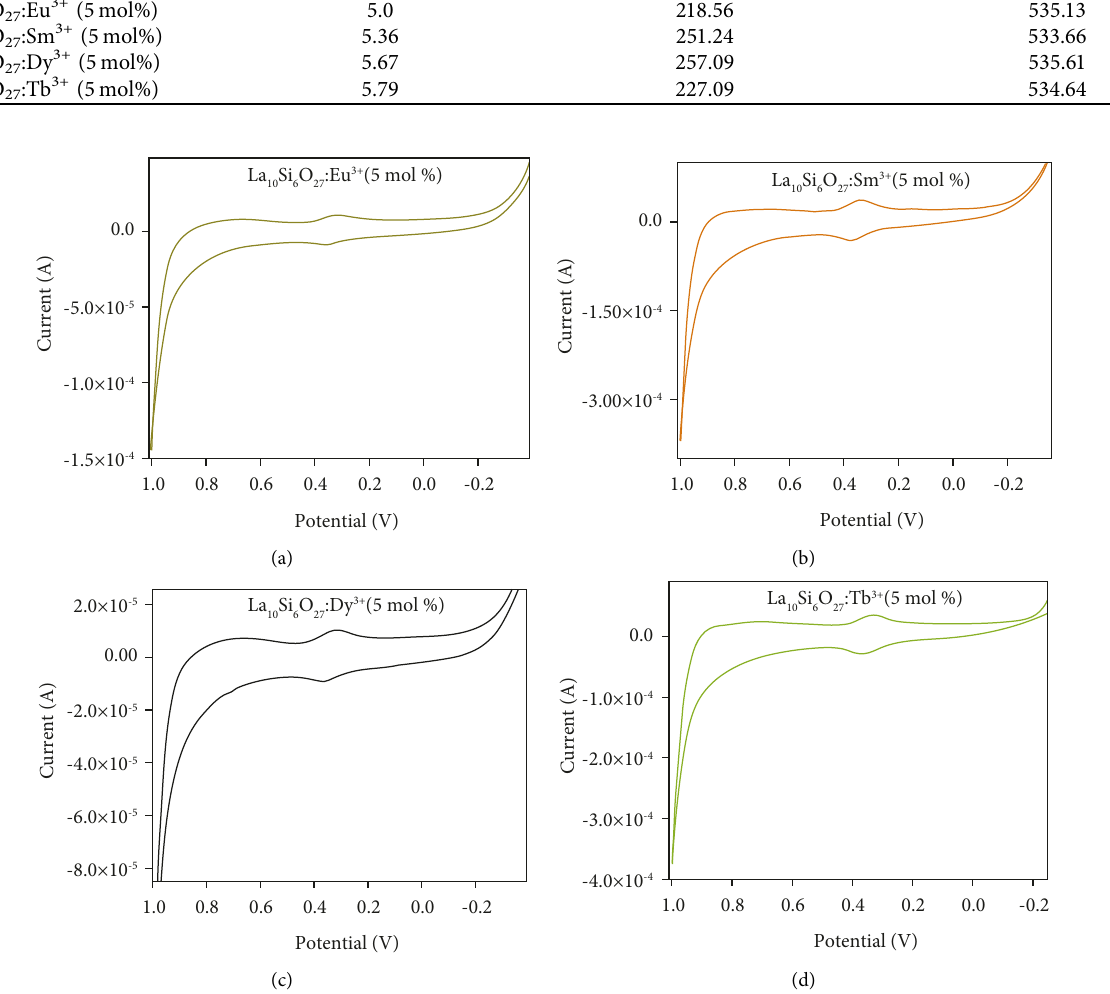
3+ (5mol%) NPs. 10 Si 6 O 27 :RE